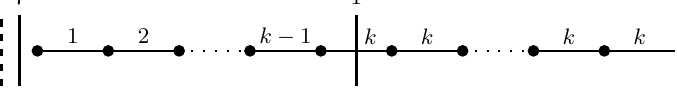
Figure 1. Type IIA configuration dual to the F-theory one in (2.2). The SCFT corresponds to the configuration where all NS5’s are brought on top of each other. Circles represent NS5’s; vertical lines represent D8’s, with their total number written on top; a dashed vertical line represents the O8 − ; horizontal lines represent D6’s, with their total number written on